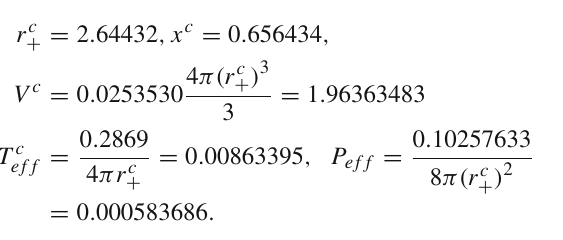
Fig. 5 Lines show T ef f , T + and T c as a function of x